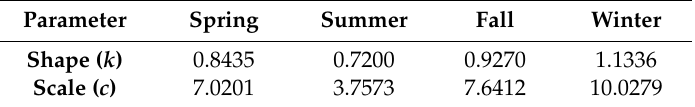
Table 4. Seasonal Weibull distribution parameters of wind power output.